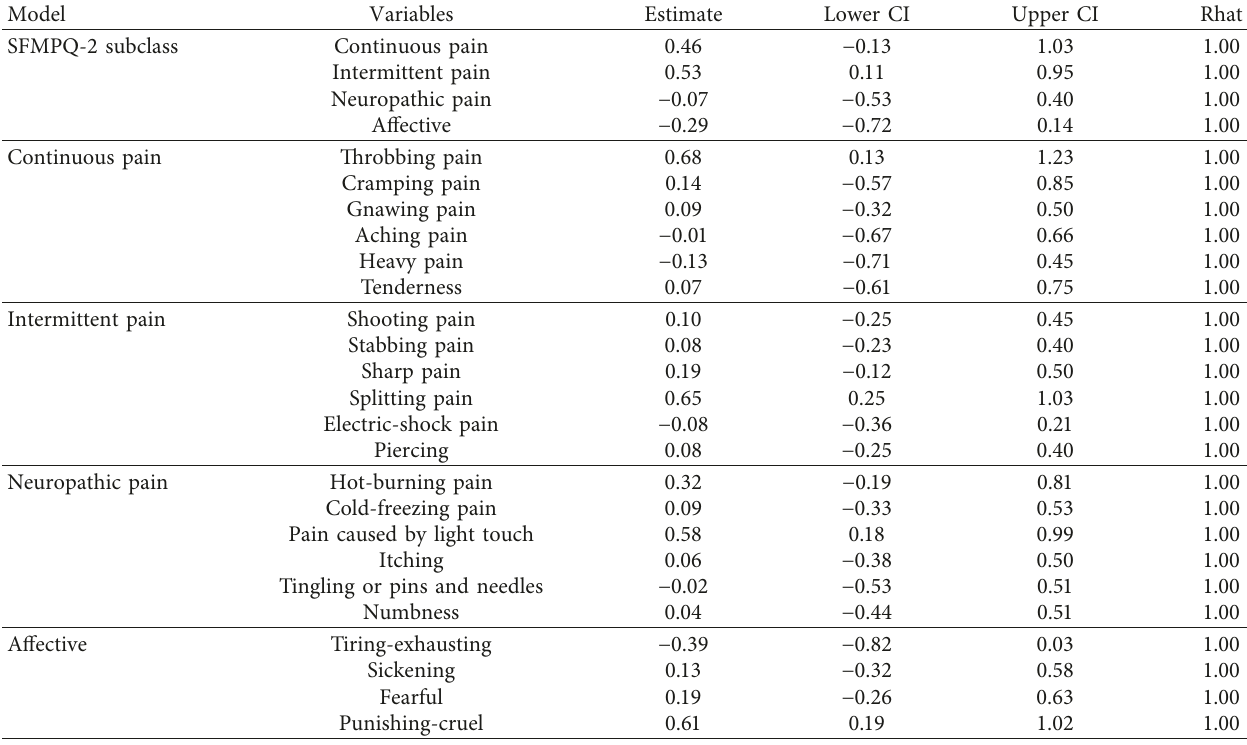
Table 3: GLMM regression results for relationship between the distance between the centroid of muscle activity and pain site and pain intensity/quality. Model